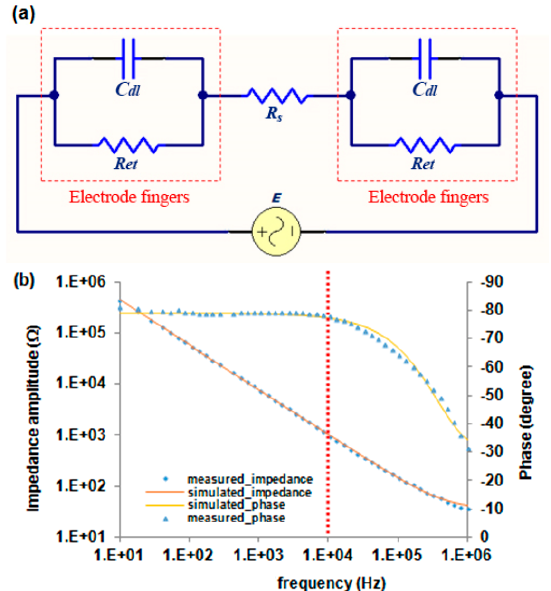
Figure 4. ( a ) The equivalent circuit of the immunosensor for detection of S . Typhimurium , and ( b )